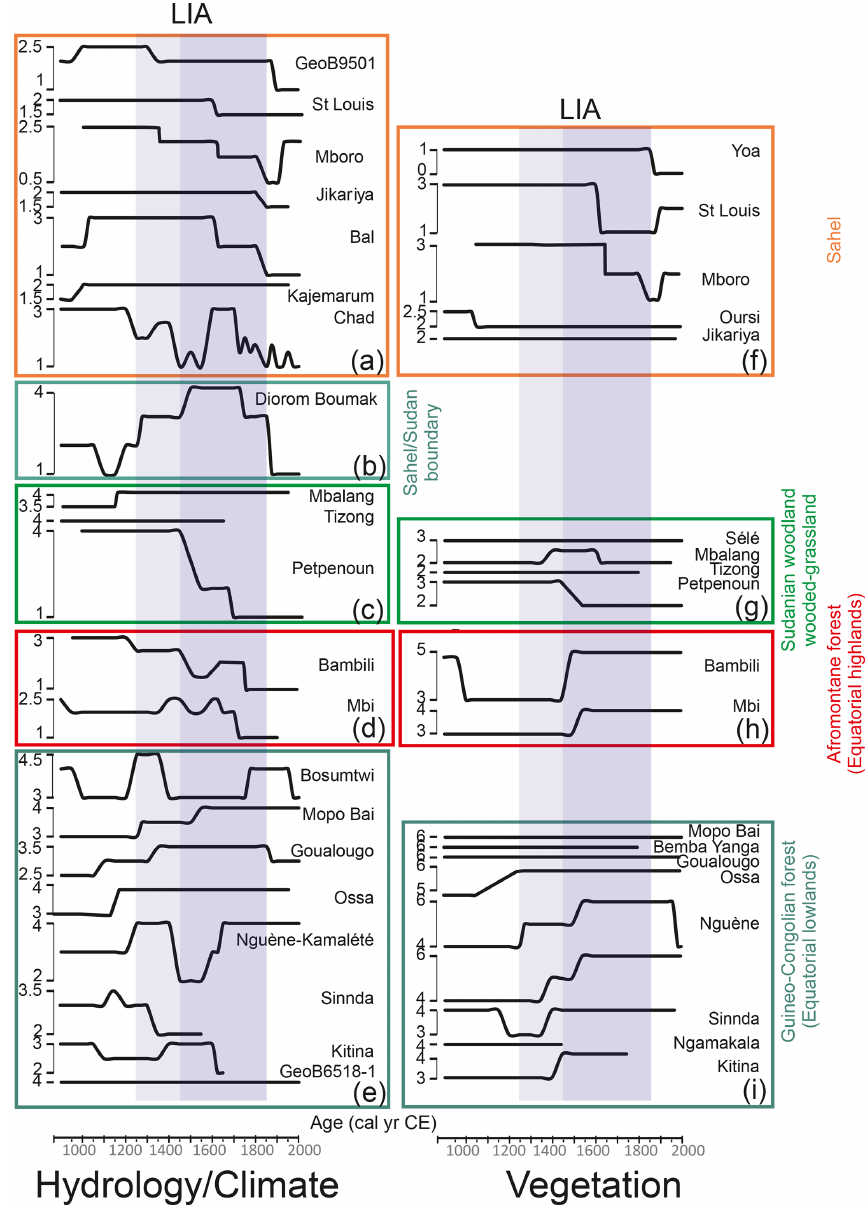
Figure 4. Mean scores of hydrological and vegetation changes along a north–south transect from the northern limit of the Sahel (Yoa) to the Congo Basin (GeoB6518-1). Data are grouped within the phytogeographical entities defined by White (1983) in tropical Africa: Sahelian grassland and wooded grassland, Sudano-Guinean savannah, highland Afromontane forest, and lowland Guineo-Congolian forest. The environmental index (bold black line) shows the evolution of vegetation from bare soil (0) to dense forest (6). The intermediate values are 1: steppe and grassland; 2: wooded grassland; 3: woodland and gallery forest; 4: degraded and secondary forest; 5: montane forest (f–i) . For hydrology and climate, the index shows the evolution from dry (1) to wet (4) with intermediate values showing the gradation between these two extremes (a–e) . The shaded vertical bands indicate the transition period between the Medieval Climate Anomaly and the Little Ice Age (1250–1450CE, light shading) and the LIA (1450–1850CE, dark